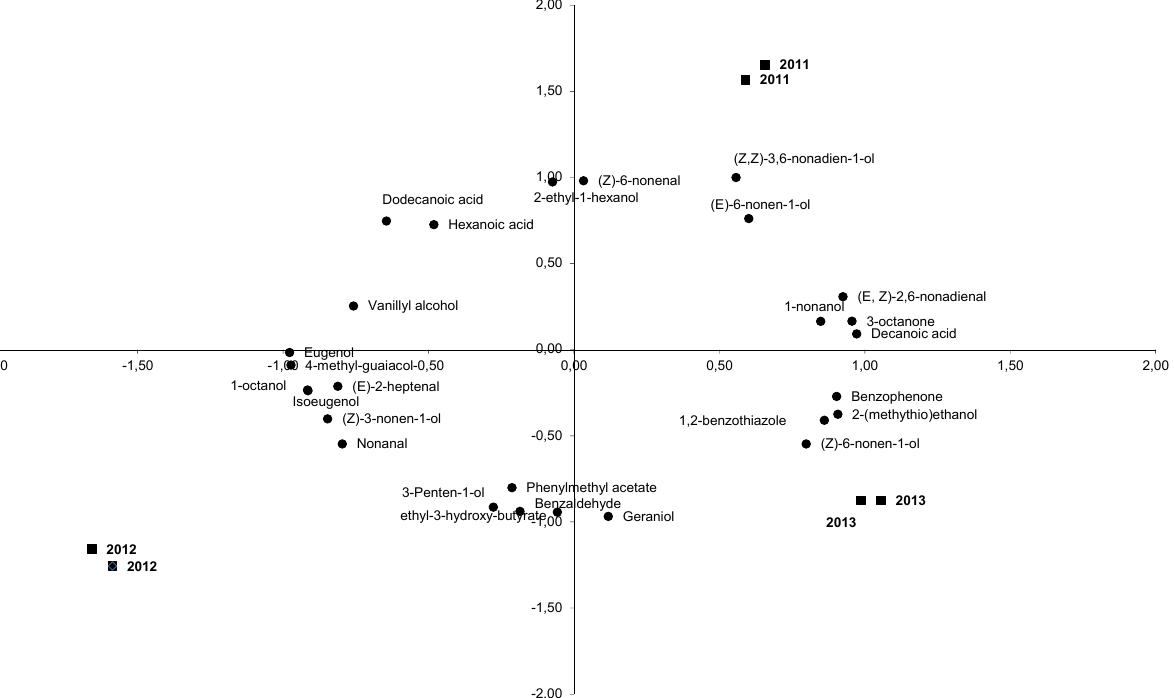
Figure 1. Distribution in the consensus space, the melon samples are written in bold and the vola Table 1. and axis 2 represents Dimension 2. Table 3. Rotated principal component loadings for volatile compounds of La Mancha Trujillo melons. Volatile